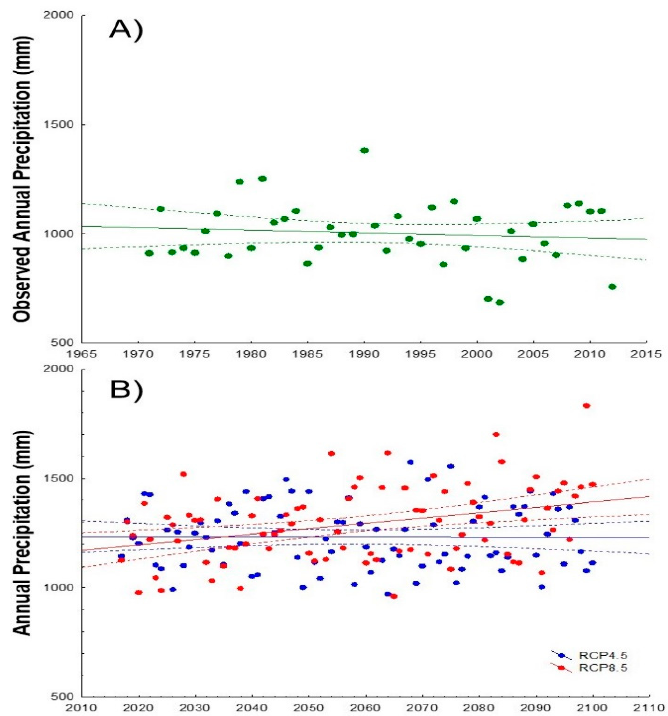
Figure 3. Annual precipitation for observed data from 1972–2012 ( A ), and modelled data for the two climate change scenarios ( B ). Linear trends (solid lines) and associated confidence intervals at a level of 95% (dashed lines) are indicated.